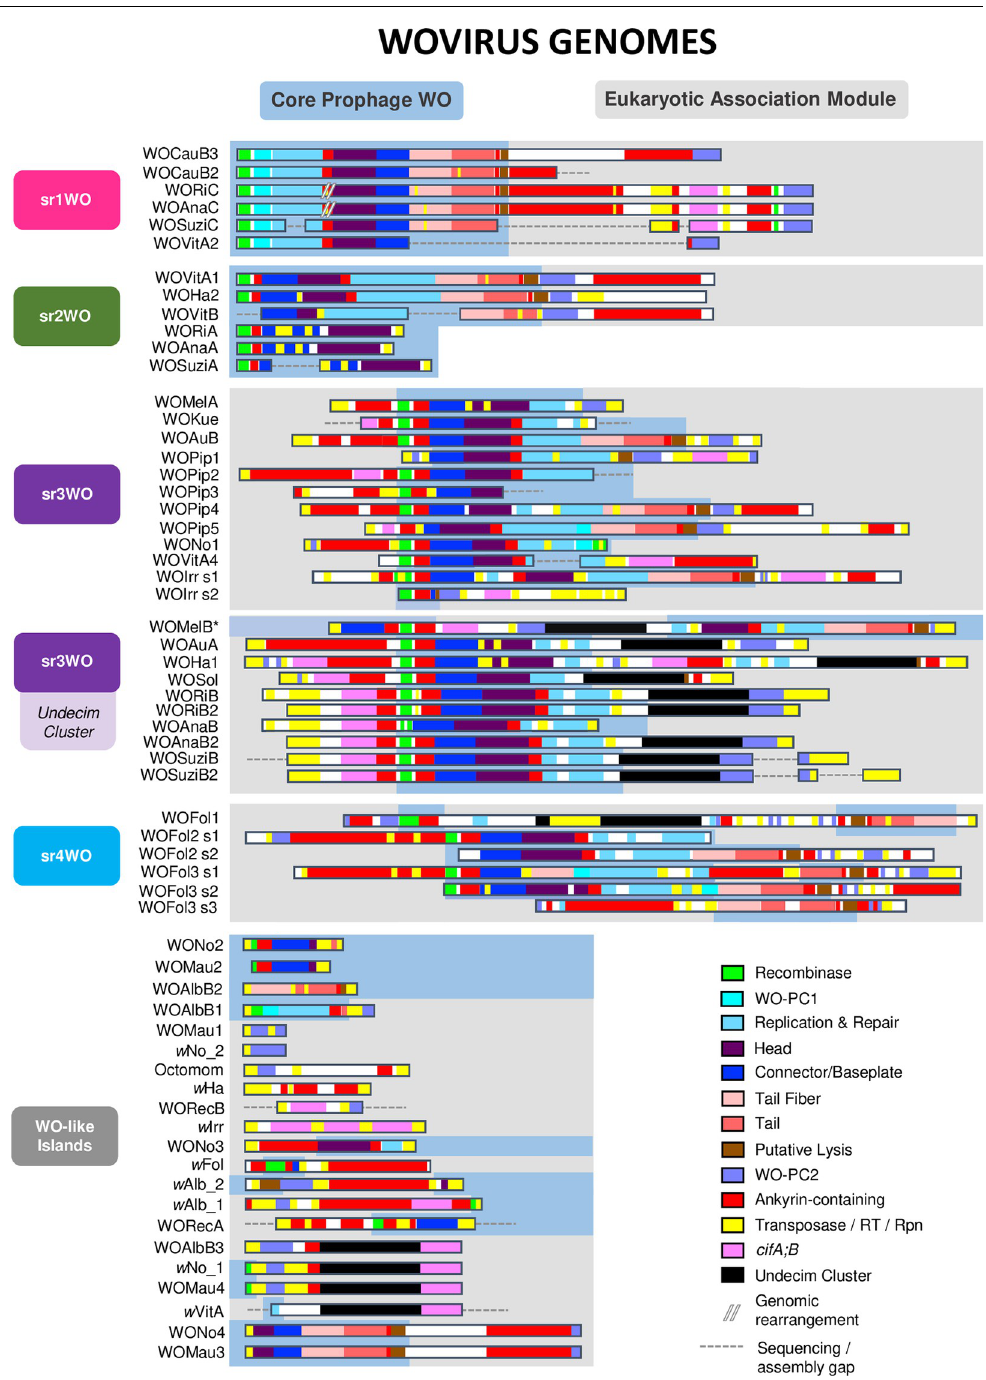
Fig 2. IntegratedWovirusgenomesfeaturedistinguishablemodulesynteny. Prophage WO variantsareorganizedbygenome contentandsyntenyoftheirstructuralmodules.Sr1WOandsr2WOfeaturea 5’-coreprophageWO region(blue)anda 3’-EAM (gray).Sr3WOfeaturesan internalcoreprophage WO regionthatis flankedby EAMgenesand mobileelements(yellow). Sr4WOis onlypresentin w Folandfeatures threegenomicregionswith multipleprophage segments.WO-likeIslandsfeature smallclustersofprophageWO-likegenes;theyare comprisedofsingularstructural modulesand/orsubsets ofEAM genes.All modulesare colorcoded:green = recombinase;turquoise= WO-PC1; light blue= replication;purple= head;blue= connector/ baseplate;light pink= tailfiber; salmon= tail;brown= putativelysis;lavender= WO-PC2; andblack= UndecimCluster.In addition,ankyrinsare showninred;transposable elementsare showninyellow;and cifA;cifB are shownin pink.Dottedlines representbreaksinthe assembly; moduleorganizationis estimated basedoncloselyrelatedvariants.Sr1WOis highlightedinhot pink;sr2WO is highlighted ingreen;sr3WO is highlighted inpurple;sr4WOis highlightedin blue;WO-like Islands are highlightedin gray. � The WOMelBgenomeis rearrangedrelativeto similarvariants.Ratherthan 5’-and3’-flankingEAM regions,modulesyntenyreflects thatofactive phageparticleswherebythe EAMis internallyoriented[39].